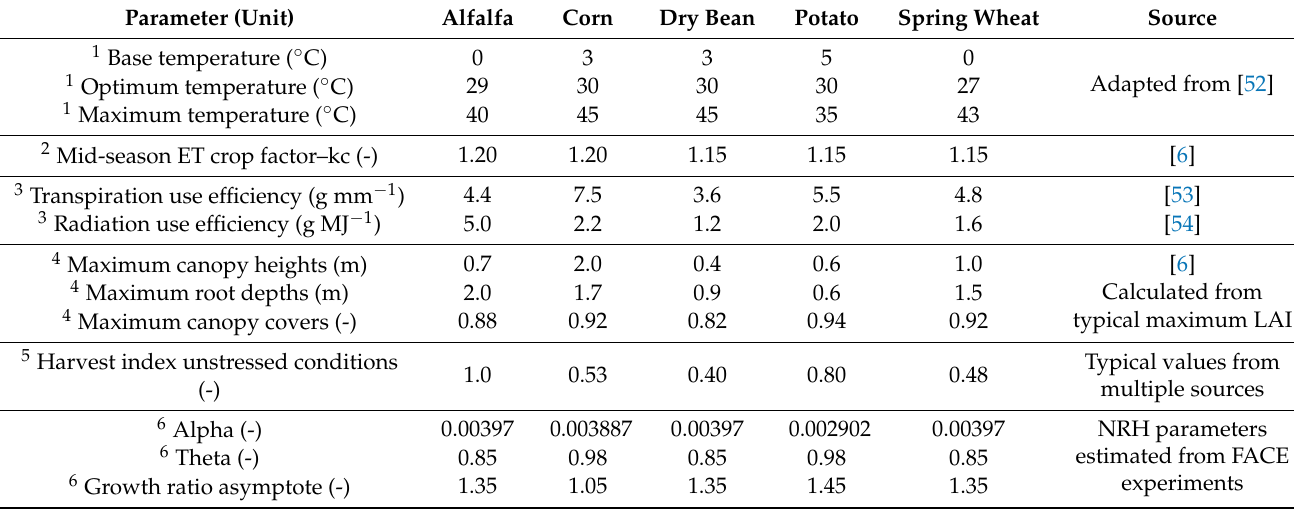
Table 3. Main crop parameters used in this study.